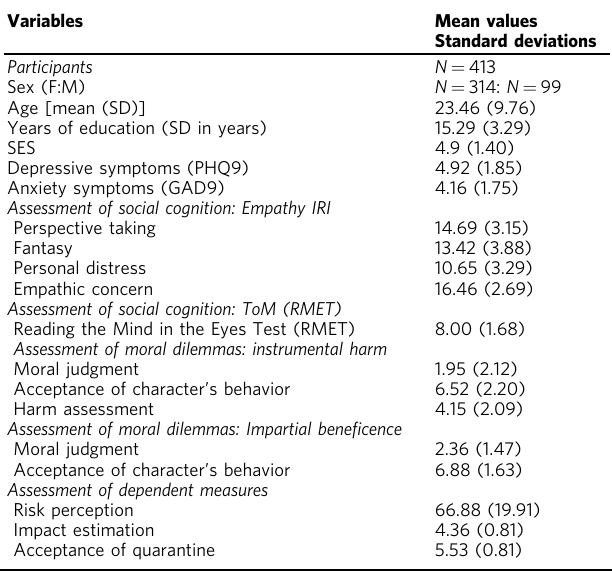
Table 1 Descriptive analysis of sociodemographic measures, prosociality predictors (social and moral cognition), and dependent